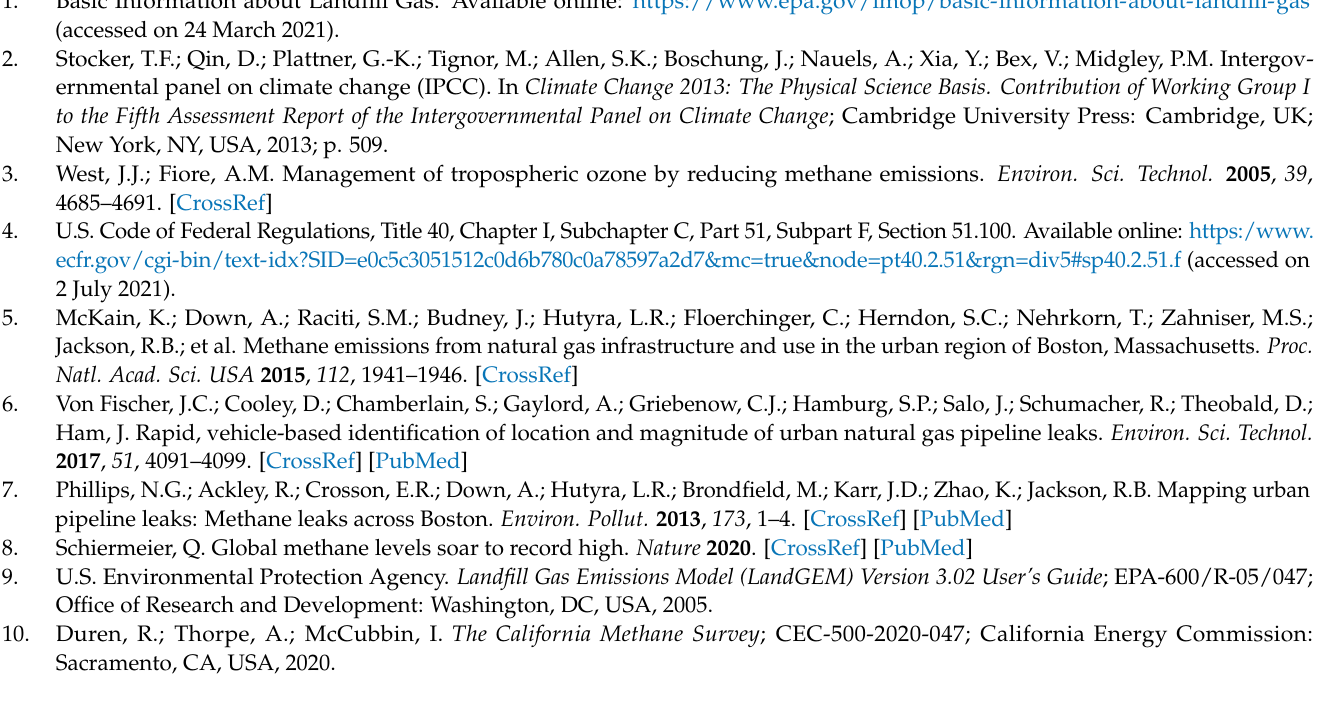
Sample molar assignments to surrogate species. Table S2: Chemical abbreviations. Table S3: Mi- croFACT_SIP chemical mechanism reactions. Table S4: Daytime chemical production and loss coefficients of long-lived species. Table S5: Chemical Jacobian terms (daytime only). Table S6: Night- time chemical production and loss coefficients of long-lived species. Table S7: Initial conditions for box model run. Table S8: Box model run parameters. Figure S1: NO concentrations predicted by MicroFACT_SIP (solid line) versus MCMv3.3.1 (dashed line) for the box model experiment. Figure S2: Same as in Figure S1, but for NO 2 . Figure S3: Same as in Figure S1, but for O 3 . Figure S4: Same as in Figure S1, but for HONO. Figure S5: Same as in Figure S1, but for HCHO. Figure S6: Same as in Figure S1, but for HNO 3